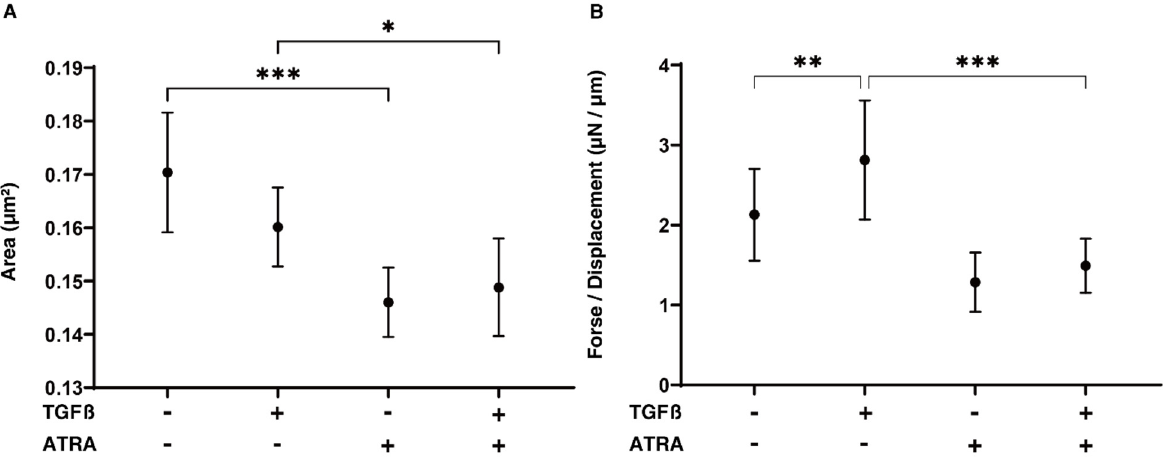
Figure 3. Effects of all- trans retinoic acid (ATRA) on the physical properties, size ( A ), and stiffness ( B ) of TGF- β 2-treated 3D HTM spheroids. Using nontreated control (NT) cultures and cultures treated with 5 ng/mL TGF- β 2 (TGF β ) in the absence or presence of 10 μ M ATRA, the mean size areas in the 3D HTM spheroids are plotted in ( A ). Their hardness was estimated by measurement of the force ( μ N) inducing a 50% semidiameter using a micro-squeezer, and force/displacement ( μ N/ μ m) values are plotted in ( B ). “+” is reagents addition. “-” is reagents non-addition. These experiments were performed in triplicate using fresh preparations ( n = 10, 30 and 15, total 45, for size measurement and stiffness analysis, respectively). Data are presented as the mean ± SEM. * p < 0.05, ** p < 0.01, *** p < 0.005; ANOVA followed by a Tukey’s multiple comparison test.